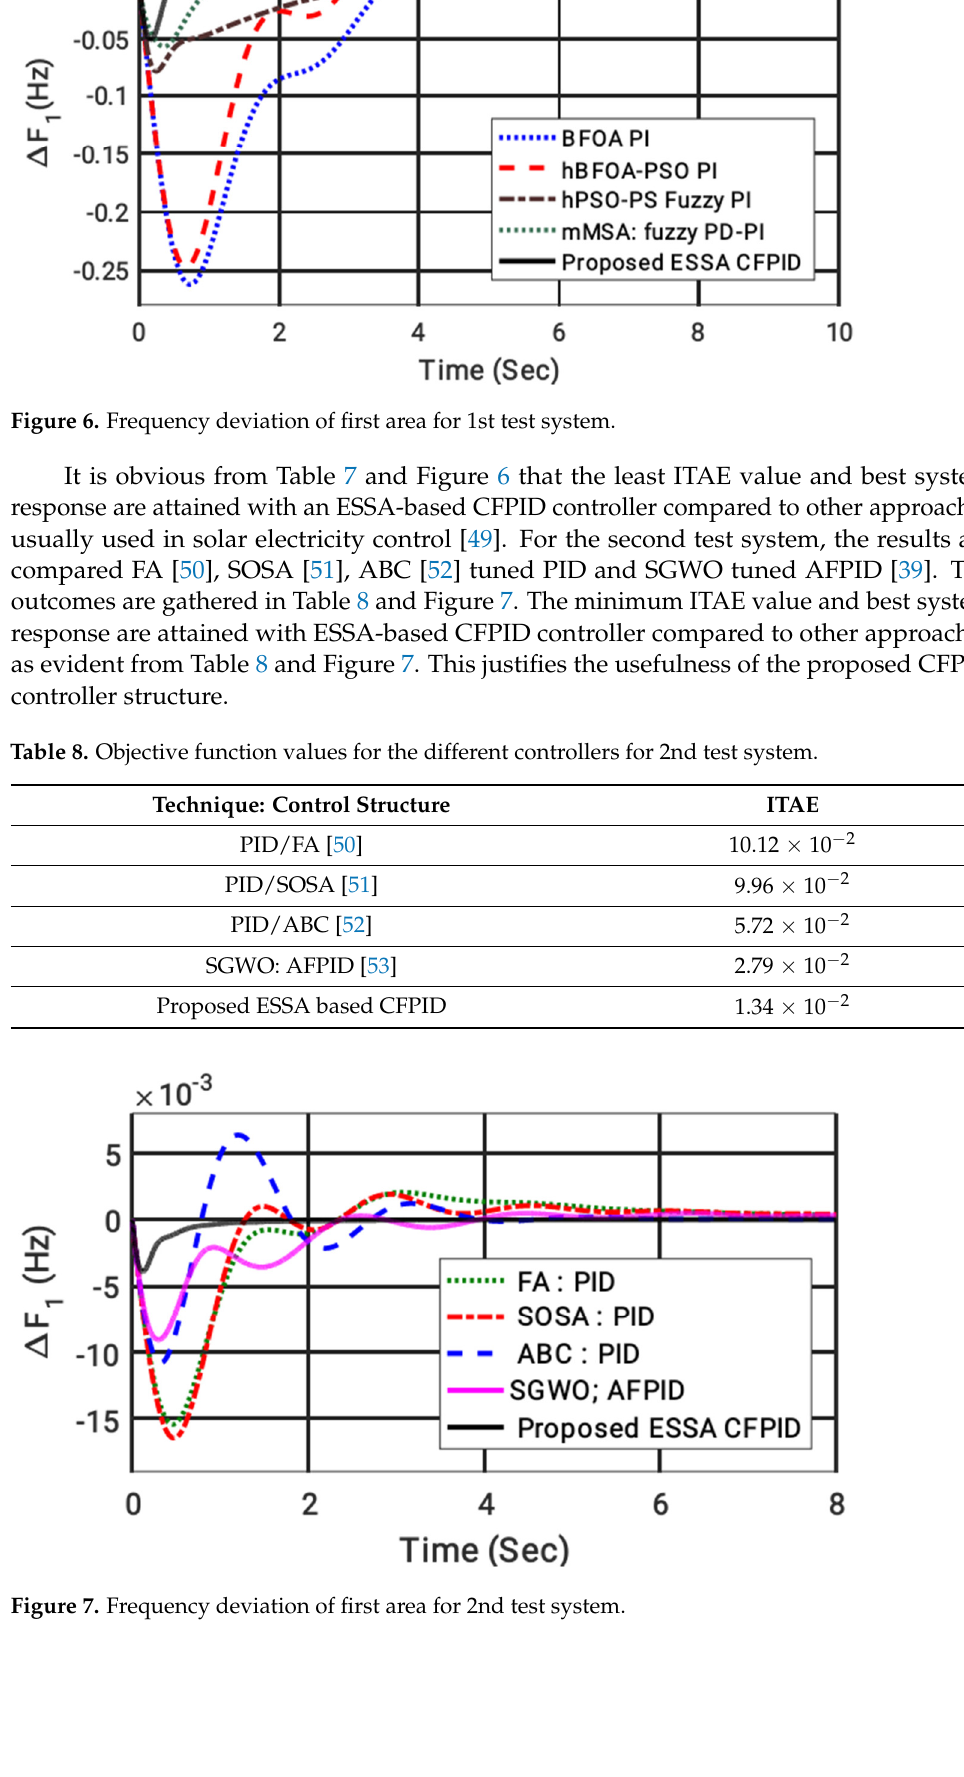
14 of 23 Table 6. Optimized parameters for two test systems. 1st test system